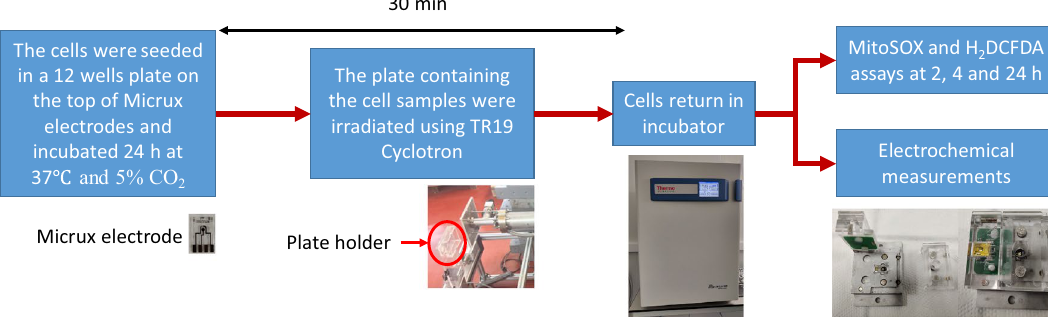
Figure 9. The workflow chart of the experimental